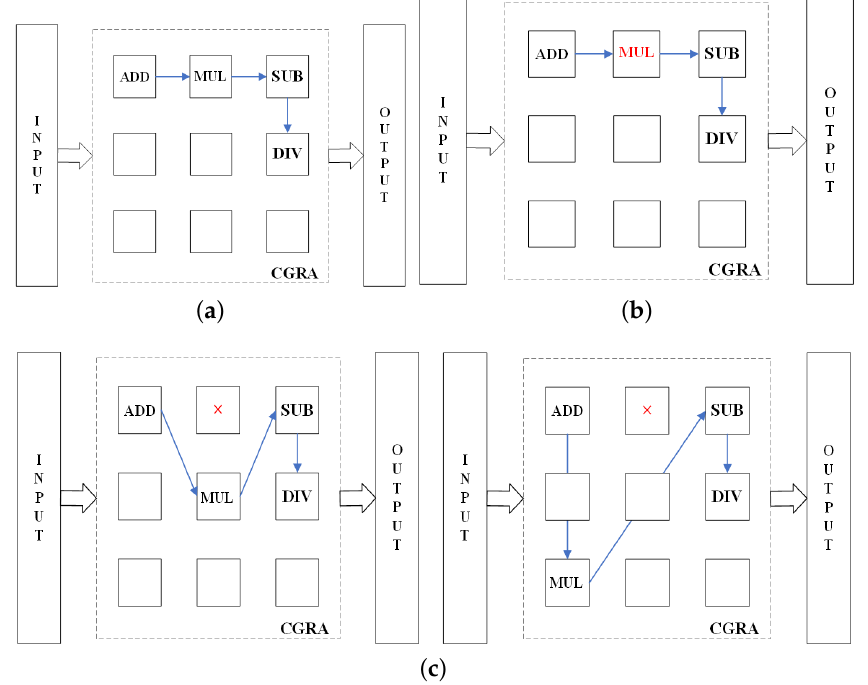
Figure 7. Description of the example circuit-I and anticipation of the HT mitigation mechanism. ( a ) original circuit-I. ( b ) HT inserted in the circuit-I. ( c ) EA-based reconfiguration to correct the circuit-I. (Red mark: the HT-I PEs; Blue Arrow: The data